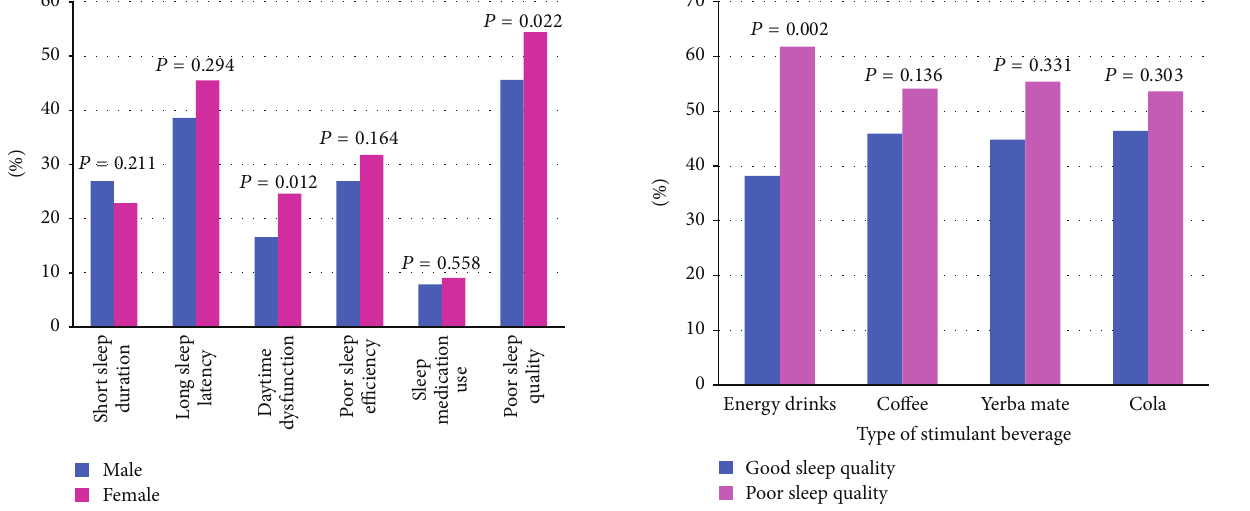
Figure 2: Sleep quality and sleep quality patterns according to gender.